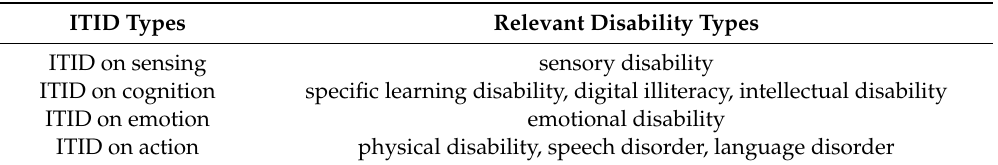
Table 2. ITID and disability